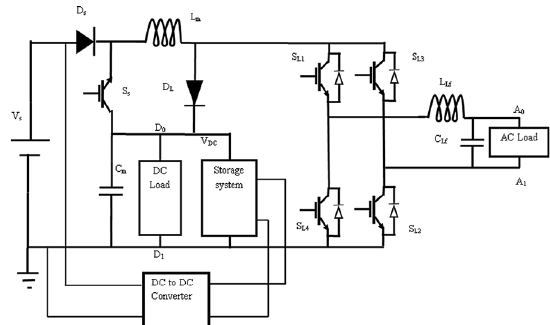
Fig. 2 Circuit diagram of proposed nanogrid